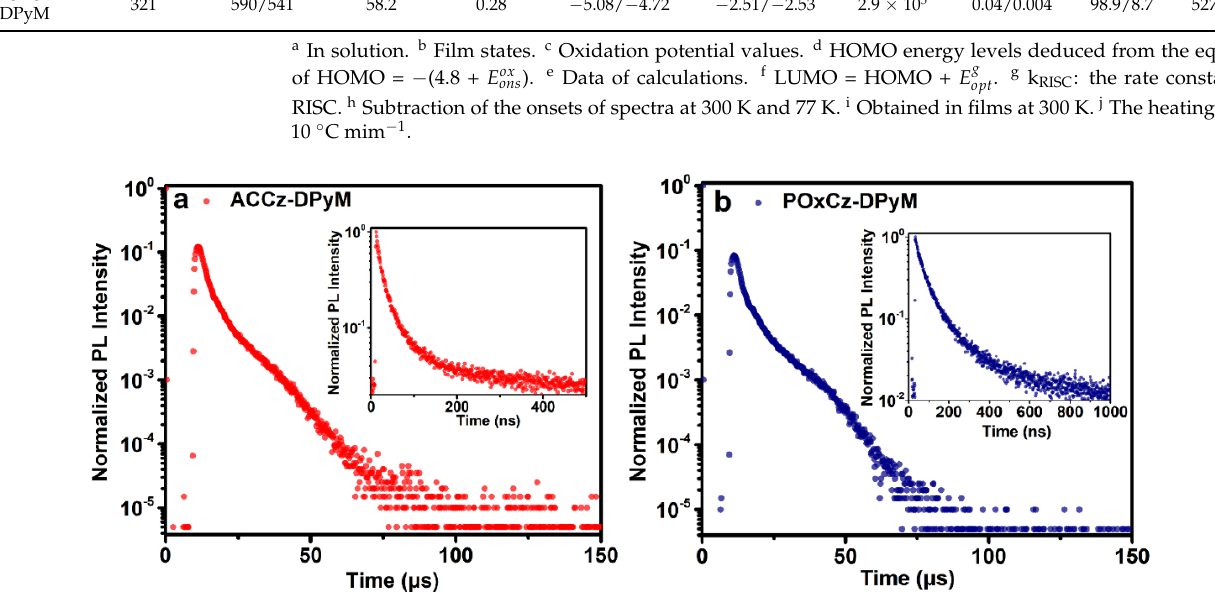
Figure 2. ( a ) UV spectra and PL spectra in dilute toluene solution for ACCz-DPyM and POxCz-